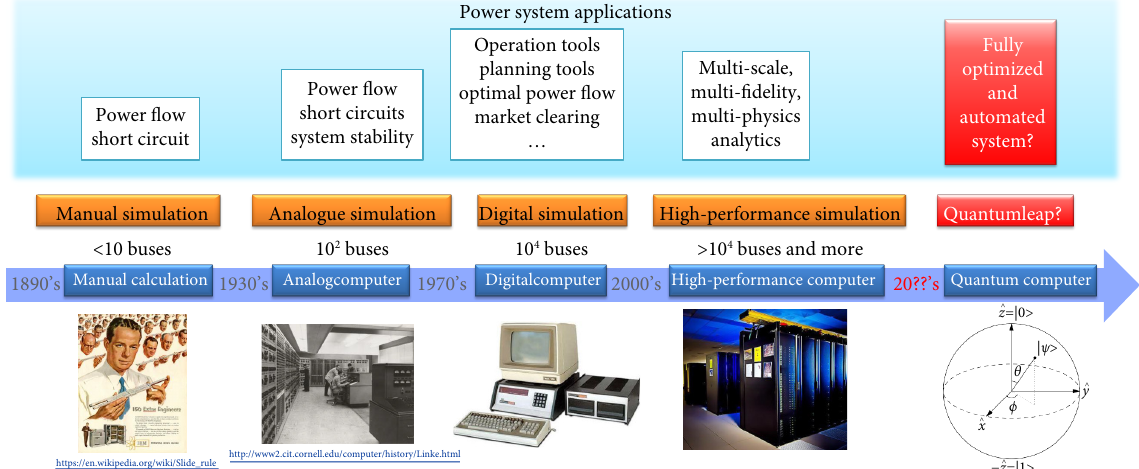
Fig. 1 Power system applications evolving with computing advancements, addressing the increasing complexity in power system planning and